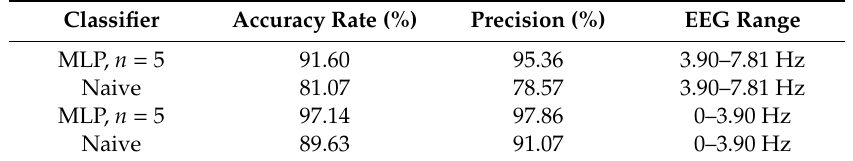
Table 5. Classification results based on different classifiers, MLP denotes Multi-layer perceptron [24].